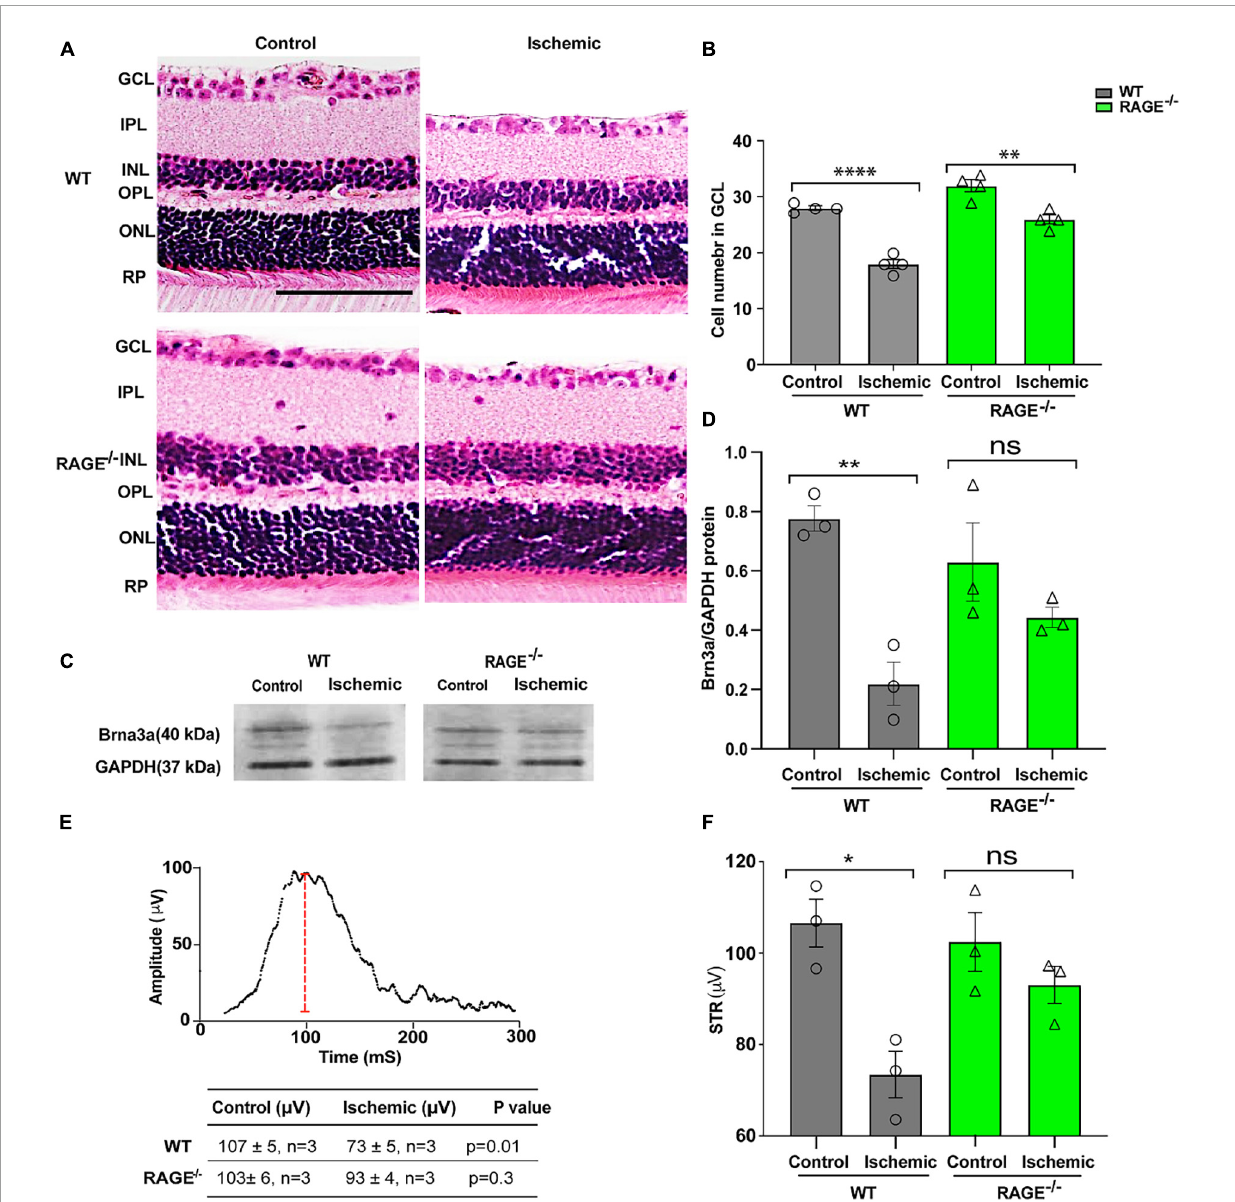
FIGURE1 RAGE − / − mice are protected against RGC loss and inner retinal dysfunction following ischemia. (A) H&E staining of WT and RAGE − / − retinal sections. (B) Comparison of the alterations of RGC numbers in WT and RAGE − / − mice after ischemia. A significant decline in RGC numbers was observed in both WT and RAGE − / − mice ( n = 4). (C) Western blotting of WT and RAGE − / − mice using Brn3a antibody showing the Brn3a band around 40 kDa. GAPDH was used as a control. (D) Densitometric analysis of Brn3a/GAPDH fold change showed a significant Brn3a downregulation in WT ischemic mice compared with WT control, but not in RAGE − / − groups. (E,F) Alterations of pSTR in WT and RAGE − / − mice after AOH. Graph representing the comparison of the pSTR decline in WT and RAGE − / − mice after AOH. * p = 0.01, ** p = 0.003, ∗∗∗∗ p < 0.0001, ** p = 0.004, ns: no significance, unpaired t- test. IPL, inner plexiform layer; INL, inner nuclear layer; ONL, outer nuclear layer, PR, photoreceptor. The scale bar is 100 µ